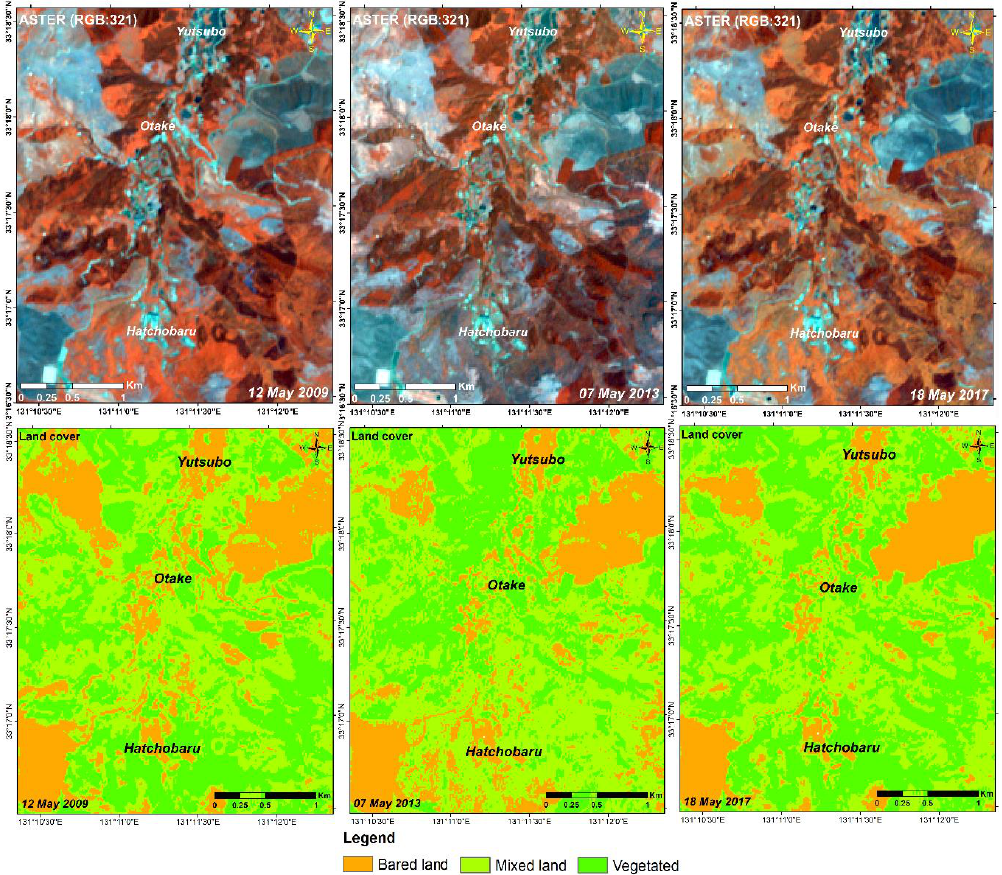
Figure 4. False colour composites of red/green/blue (RGB) visible bands of ASTER satellite data for the study area for 2009, 2013, and 2017 (top row). The bottom row shows the maps of the landcover types within the study area for 2009, 2013, and 2017. Locations of the Hatchobaru, Otake, and Yutsubo hot spring areas are shown on all of the images.